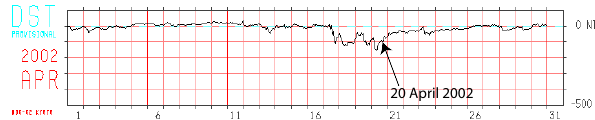
Fig. 12. D st index values for April 2002. On the 20 April 2002 storm conditions are observed, while Cluster is passing through perigee. At 18:00 UT, the D st index was about − 101nT.